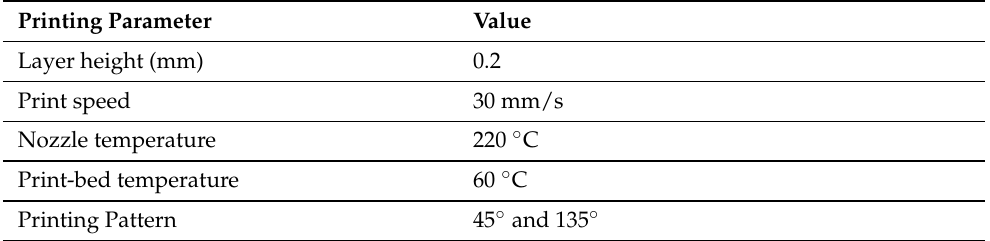
Table 2. Values of variable parameters used to perform 3D printing of various